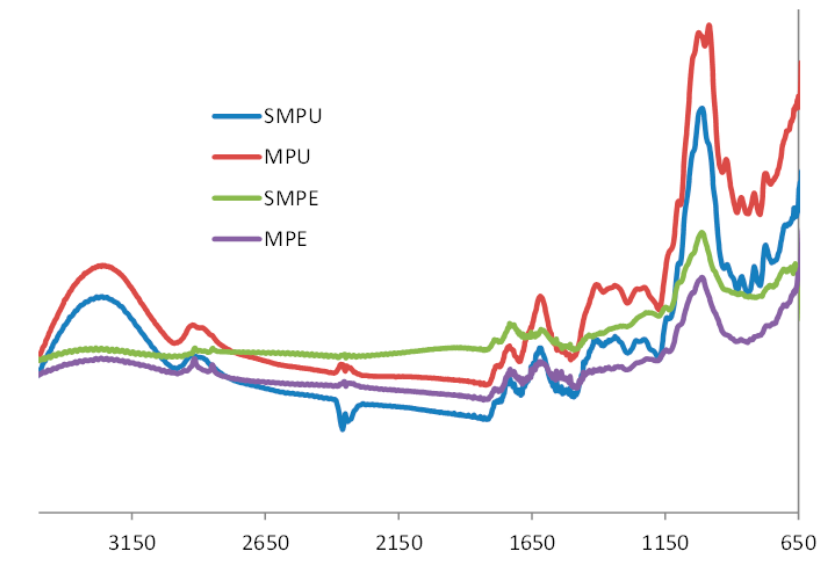
Figure 1. FTIR spectra for umbu peels and pulps. MPE: mature peel; SMPE: semi-mature peel; MPU: mature pulp; SMPU: semi-mature pulp.